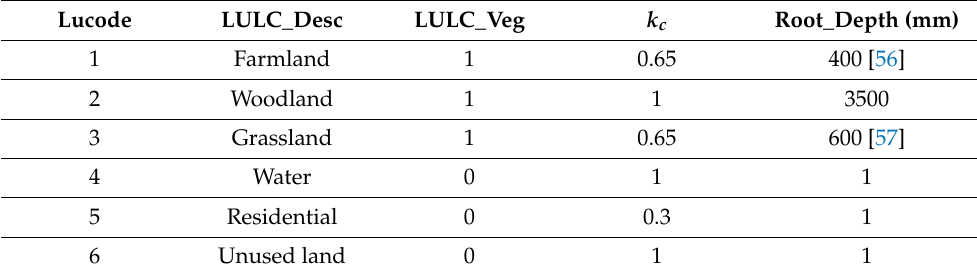
Table 2. Table of biophysical coefficients for the water yield module of the InVEST model. Lucode